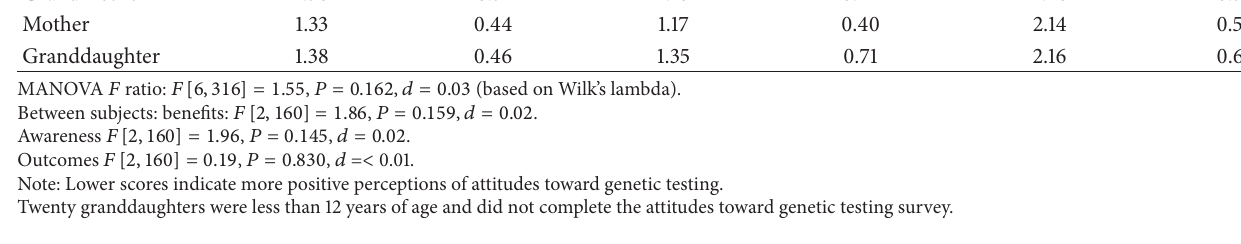
Table 4: One-way MANOVA—subscales measuring attitudes toward genetic testing by age of participants. Subscales Age Benefits Awareness Outcomes M SD M SD M SD 21 years and younger 1.62 0.54 1.60 0.97 2.29 0.53 a a,b 0.40 1.16 0.35 2.05 0.53 22 to 50 1.28 a a 0.49 1.18 0.45 2.25 0.57 Over 50 years 1.45 a b MANOVA 𝐹 ratio: 𝐹[6,316] = 3.90 , 𝑃 = 0.001 , 𝑑 = 0.07 (based on Wilk’s lambda). Between subjects: benefits: 𝐹[2,160] = 5.19 , 𝑃 = 0.007 , 𝑑 = 0.06 . Awareness 𝐹[2,160] = 6.49 , 𝑃 = 0.002 , 𝑑 = 0.08 . Outcomes 𝐹[2,160] = 3.01 , 𝑃 = 0.052 , 𝑑 = 0.04 . Note: Lower scores indicate more positive perceptions of attitudes toward genetic testing. Means in a column sharing subscripts are significantly different. Twenty granddaughters were less than 12 years of age and did not complete the attitudes toward genetic testing